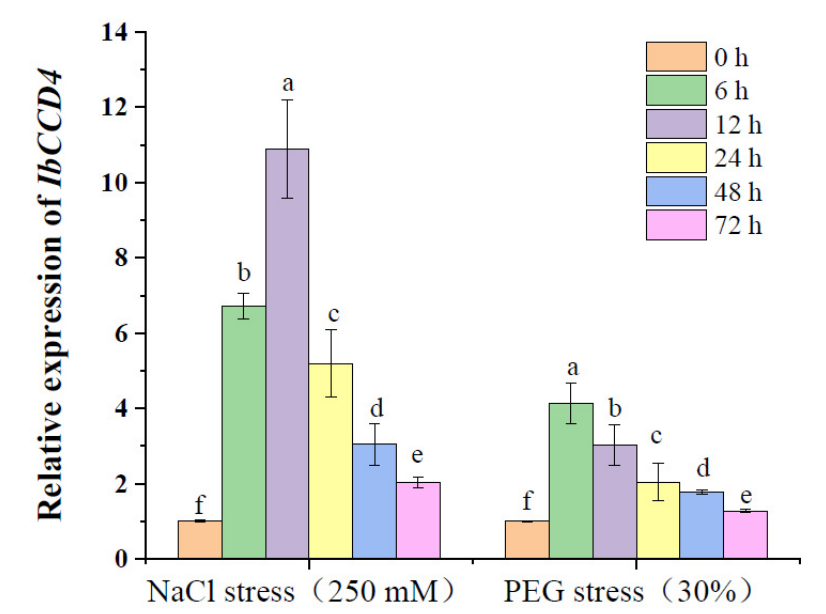
Figure 2. The expression of IbCCD4 in leaves of sweet potato under 250 mM NaCl of salt stress and 30% PEG of dehydration stress. Different letters indicate the significant differences under the same treatment ( p < 0.05).